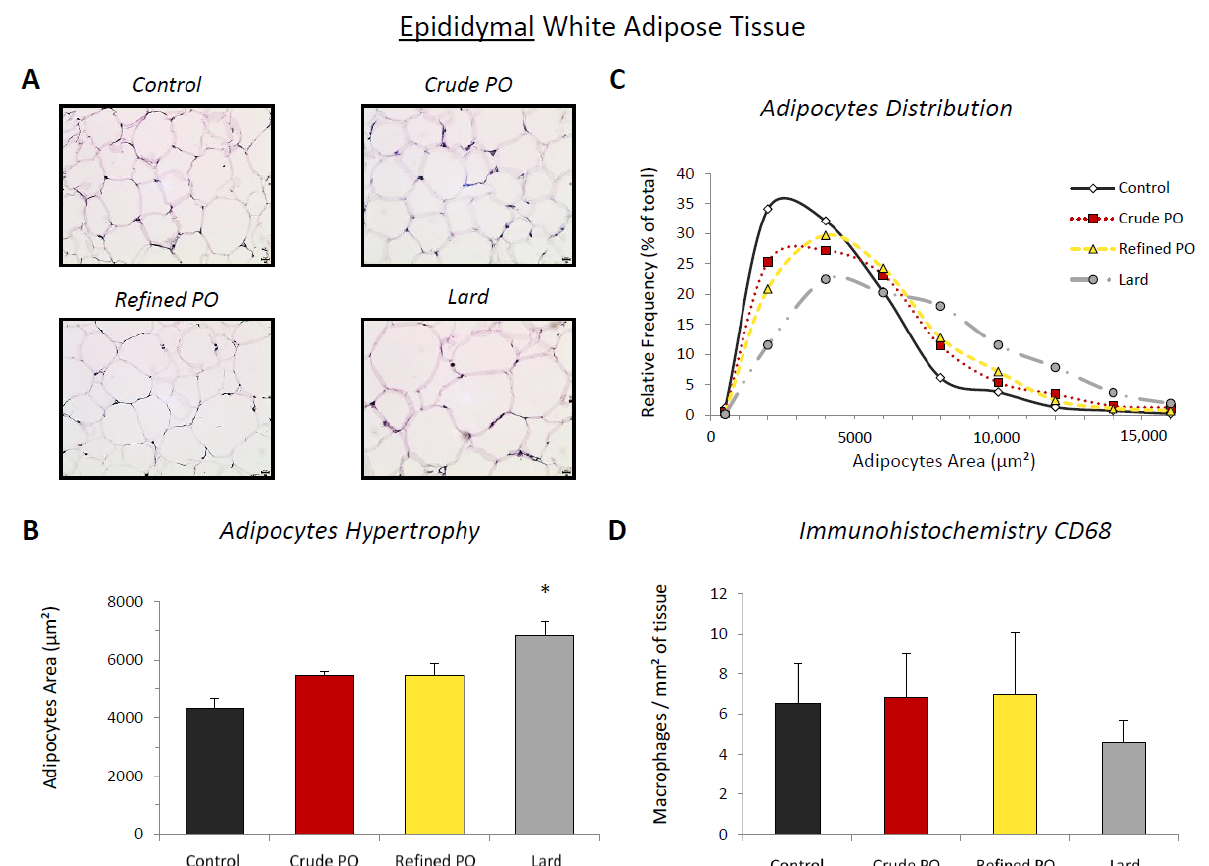
Figure 1. Adipocyte size and macrophage infiltration in epididymal white adipose tissue (eWAT). ( A ) Representative microphotographs of haematoxylin staining ( × 200; scale bar = 20 µ m); ( B ) quantitative analysis of adipocyte area ( µ m 2 ); ( C ) relative frequency of adipocyte area (%); ( D ) quantitative analysis of immunohistochemistry for CD68 (number of positive cells/mm 2 of adipose tissue). Data are shown as means ± SEM, n = 4–7 animals per group. * p < 0.05 vs. control